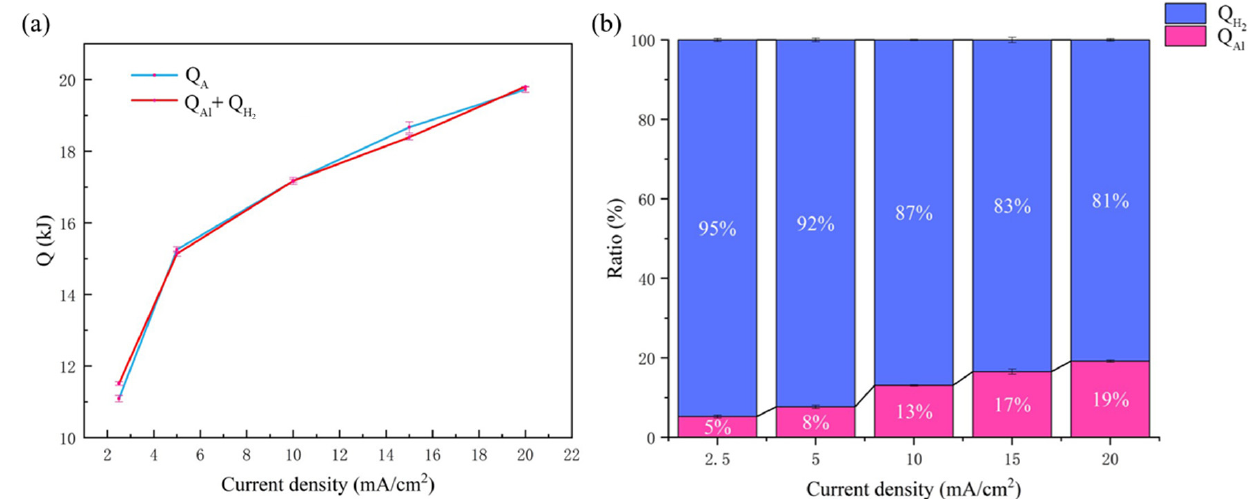
Figure 7. ( a ) Q A with different discharge current densities measured by direct and indirect methods and ( b ) the proportion of Q Al and Q H in Q A of the aluminum–air battery. According to Equation (8) and relevant analysis of Q R , Q J , and Q P , Q tol can be ex- pressed by Equation (34):